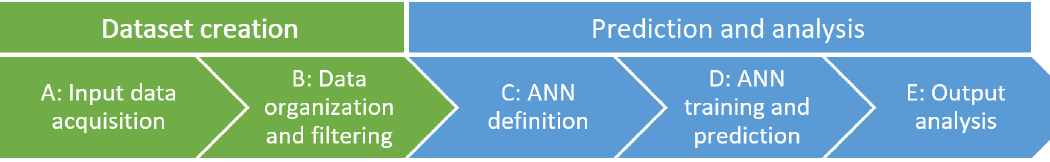
Figure 3. Methodology